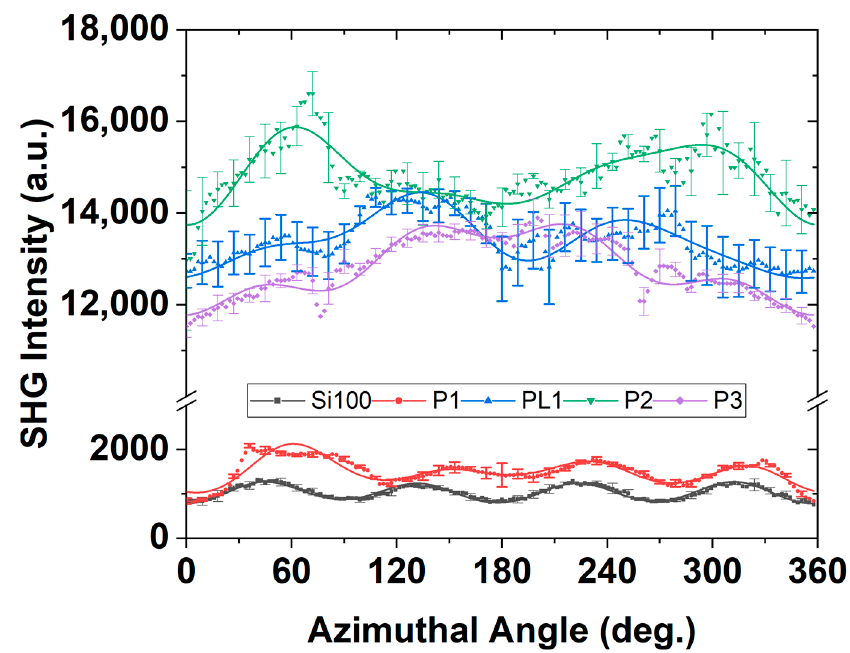
Figure 9. pp -polarized Ani-RSHG spectrum of P-doped Si(100).